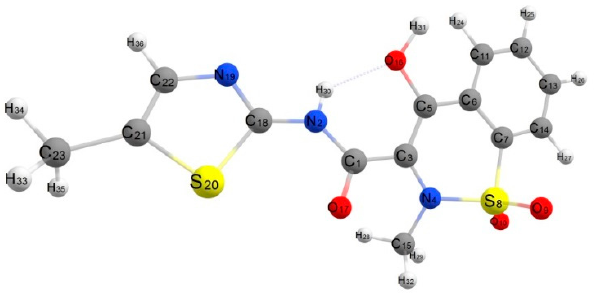
Figure 3. Density functional response theory (DFT) optimized geometry of H 2 mel.